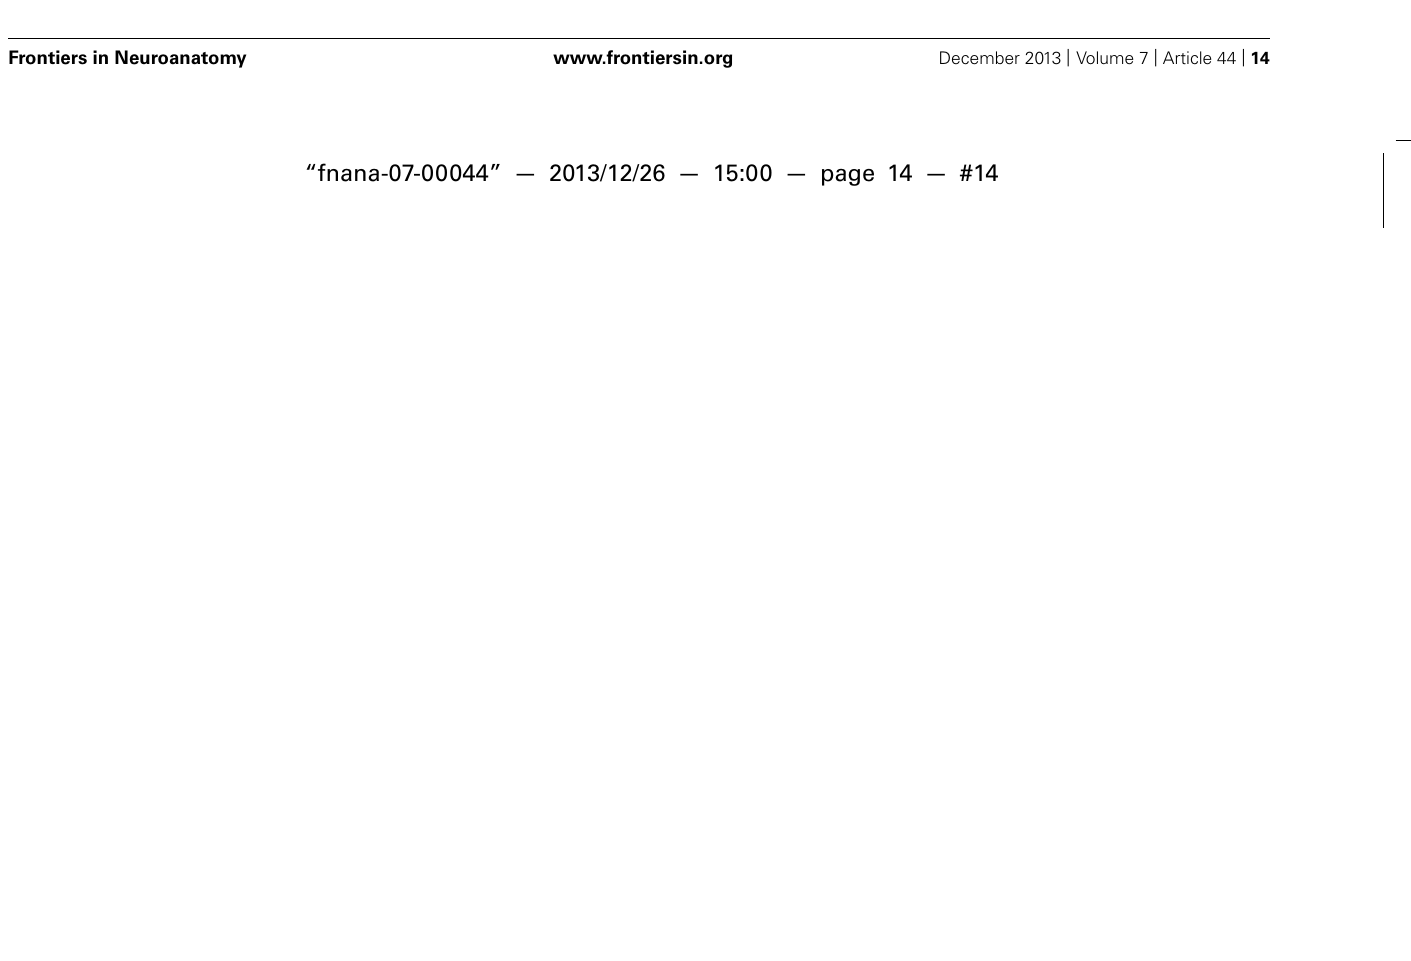
in the spinal cord and brain cortex at week 2 (E) and week 8 (F) postimmunization revealed byWestern blotting. a P < 0.05 versus normal control; b P < 0.05 versus vehicle-treated EAE rats; c P < 0.05 versus C16-treated EAE rats; d P < 0.05 versus CNTF-treated EAE